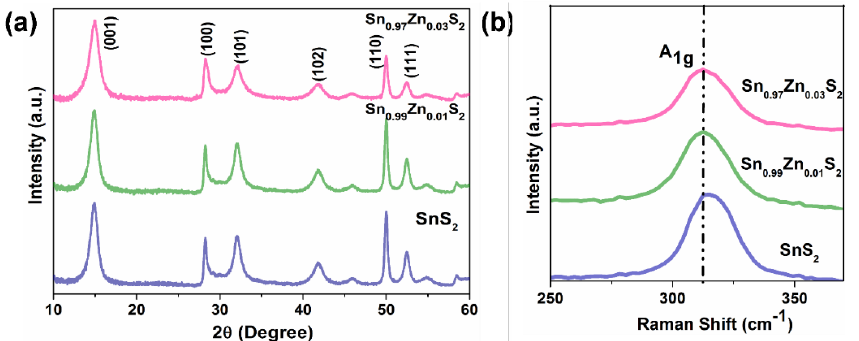
Figure 4. Structure properties of SnS 2 , Sn 0.99 Zn 0.01 S 2 and Sn 0.97 Zn 0.03 S 2 nanoflakes. ( a ) X-ray diffraction pattern of SnS 2 , Sn 0.99 Zn 0.01 S 2 and Sn 0.97 Zn 0.03 S 2 nanoflakes; ( b ) Raman spectrum of SnS 2 , Sn 0.99 Zn 0.01 S 2 and Sn 0.97 Zn 0.03 S 2 nanoflakes at excitation wavelength of 532 nm.